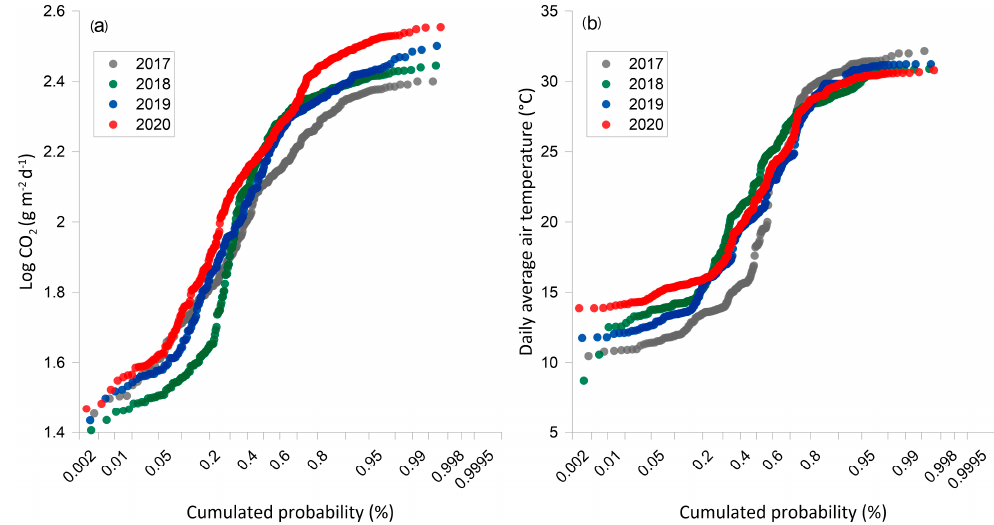
Figure 6. ( a ) Cumulated probability of CO 2 fluxes calculated and plotted for each year of acquisition. The increase of the higher and lower family’s values for each year from 2017 to 2020 is visible. ( b ) The cumulated probability of air temperature plotted for each year shows a clear decrease of higher family’s values (hot temperature) from 2017 to 2021 and an increase of lower family’s values (cold temperature).